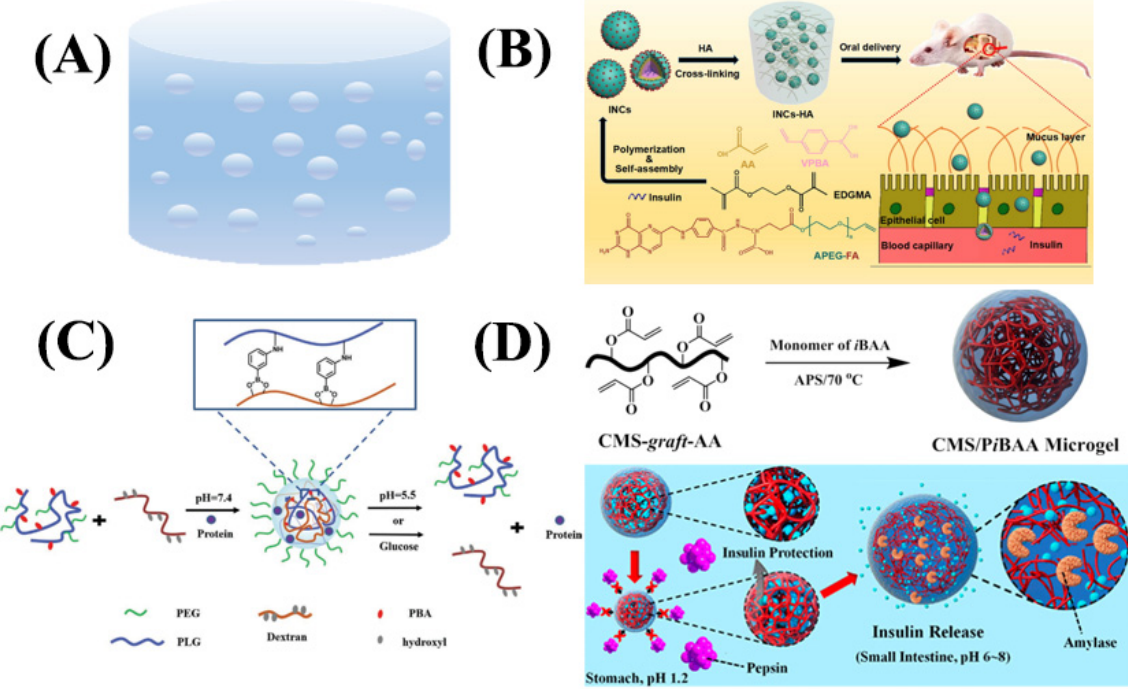
Figure 7. ( A ) Structure of nanogel. ( B ) Schematic representation of insulin-loaded glucose-responsive nanocarriers further encapsulated into hyaluronic acid (HA) hydrogel for oral delivery of insulin. ( C ) Schematic diagram of pH and glucose dual-responsive nanogels for protein delivery. ( D ) Synthetic process and its pH responsiveness of CMS/PiBAA hybrid microgel.